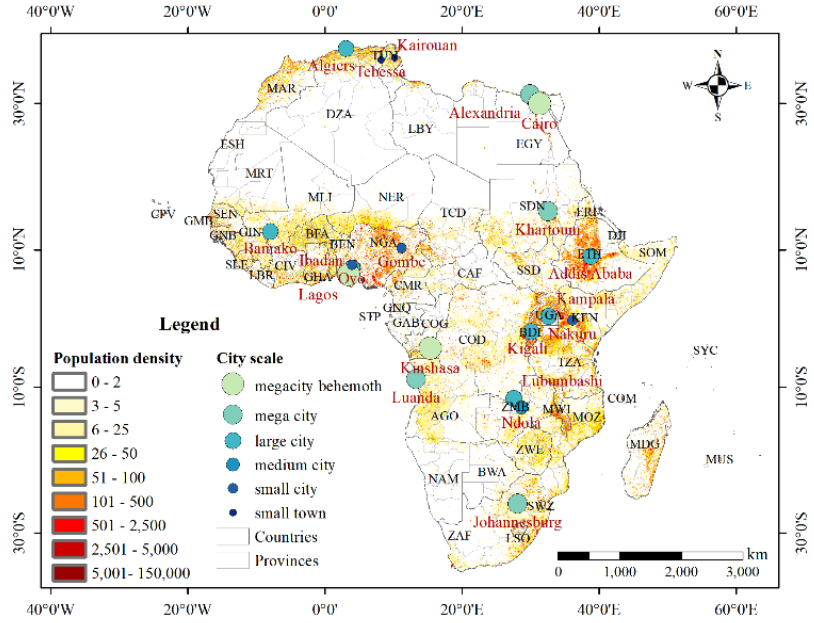
Figure 1. Location of 20 evaluated cities and population density from LandScan in 2018. Table 1. Classification standard of city-scale and cities included.